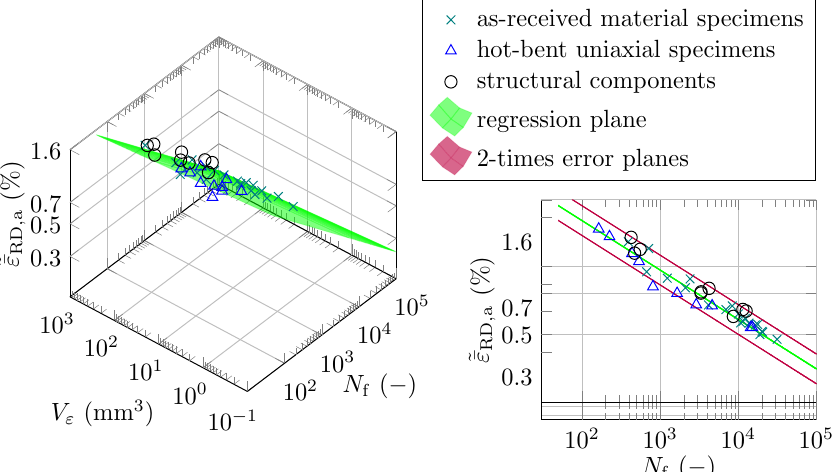
Figure 13. Three-dimensional and two-dimensional ˜¯ ε RD,a - V ε - N f fatigue diagrams by applying the CH ε V with combined regression parameters from results of low-cycle fatigue tests of the as-received material specimens and hot-bent uniaxial